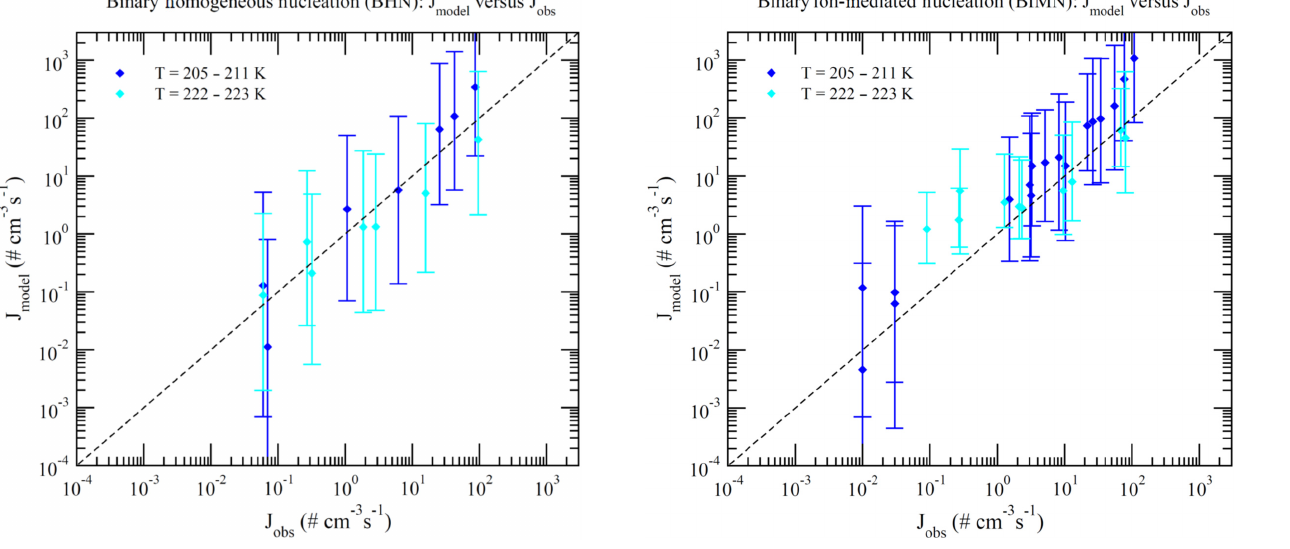
Figure 2. Same as Fig. 1 but for BIMN conditions (with ionization, [ NH ] < 0 . 1ppt). 3